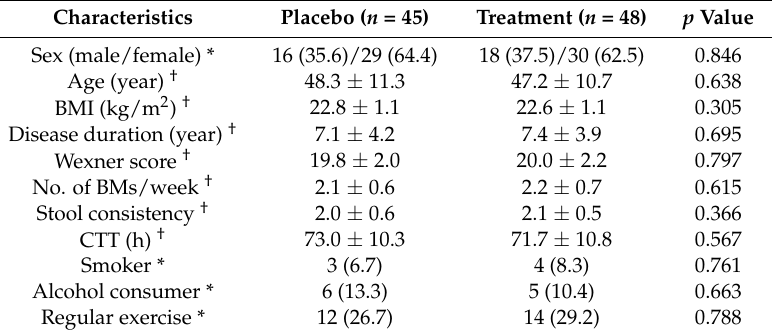
Table 1. Baseline demographics in patients received treatment or placebo.